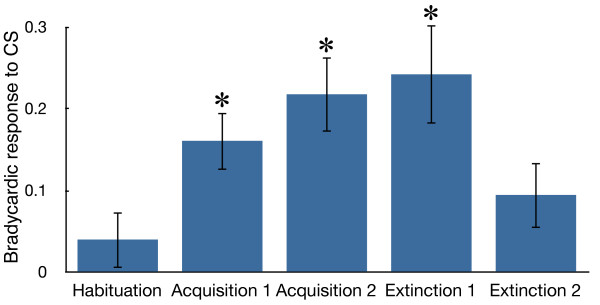
Classical fear conditioning results. Comparison of the magnitudes (mean ± SEM) of the bradycardic responses in the habituation sessions, the first ten trials of the acquisition sessions (Acquisition 1), the last ten trials of the acquisition sessions (Acquisition 2), the first five trials of the extinction sessions (Extinction 1), and the last ten trials of the extinction sessions (Extinction 2). * denote significant differences relative to the habituation levels (Steel test, p < 0.05).